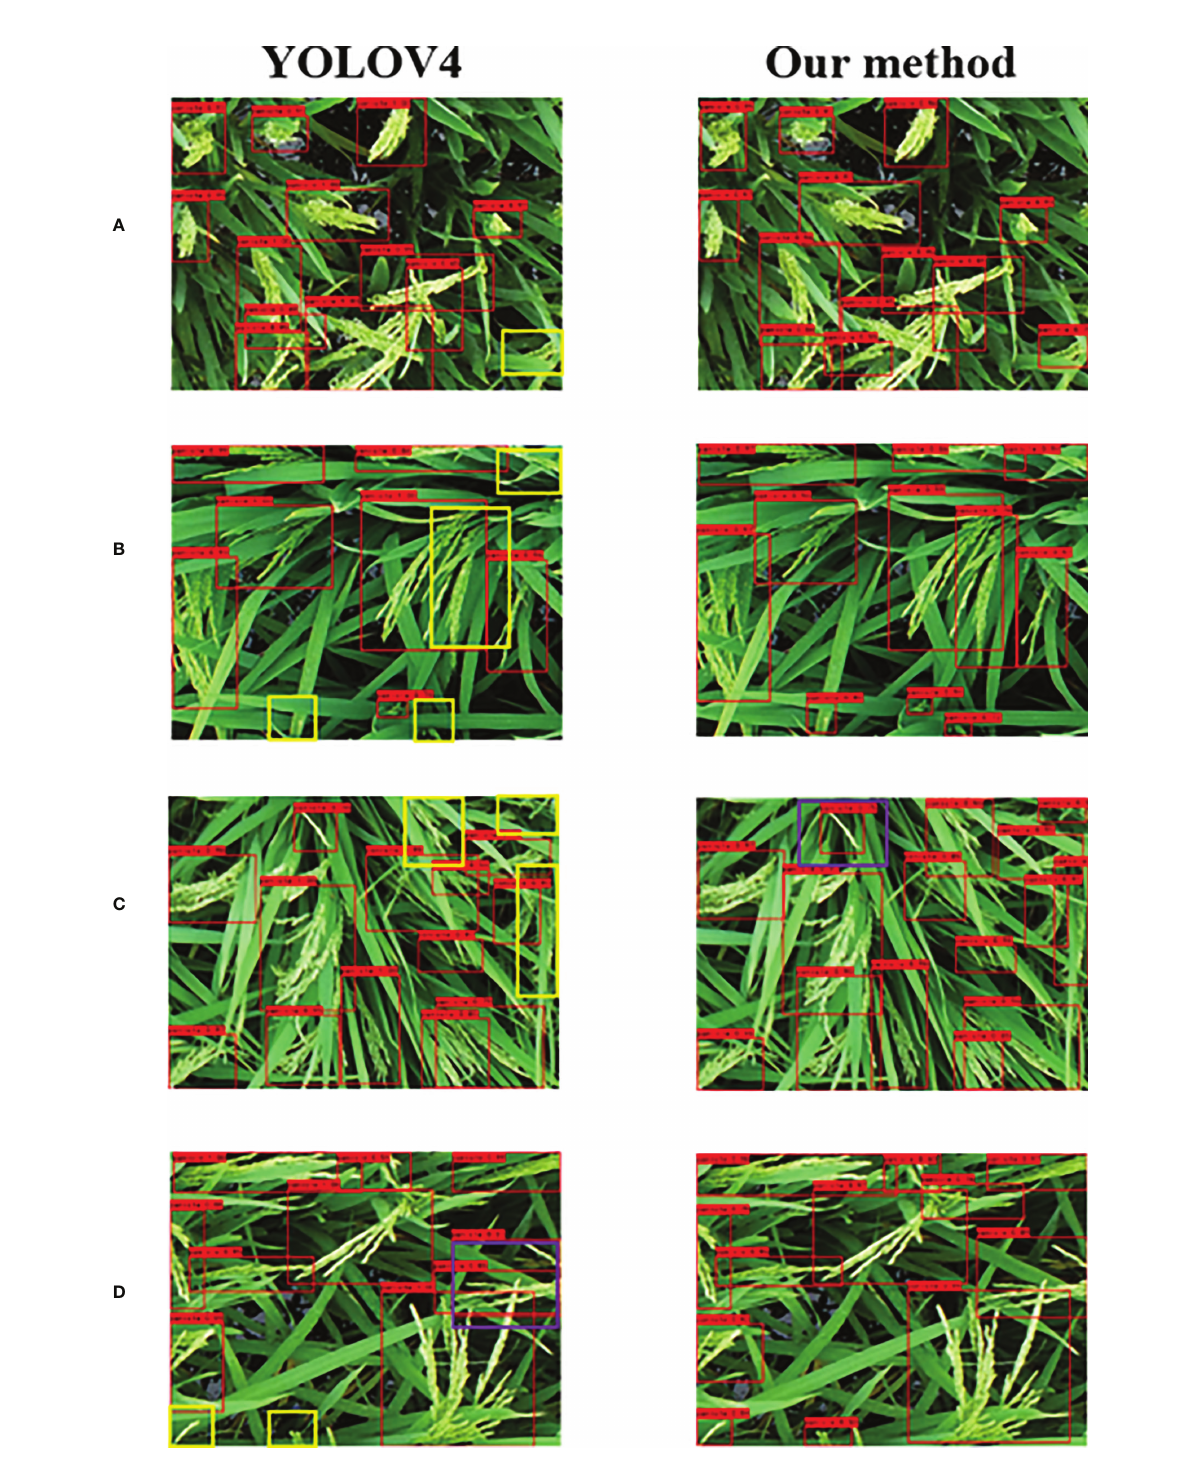
FIGURE 6 Recognition effects of YOLOv4 model (left) and the improved algorithm in this study (right). (A) Independent dataset recognition; (B) leaf-above spike type; (C) spike-above leaf type; (D) middle type. The yellow and purple boxes represent missed and false detection,